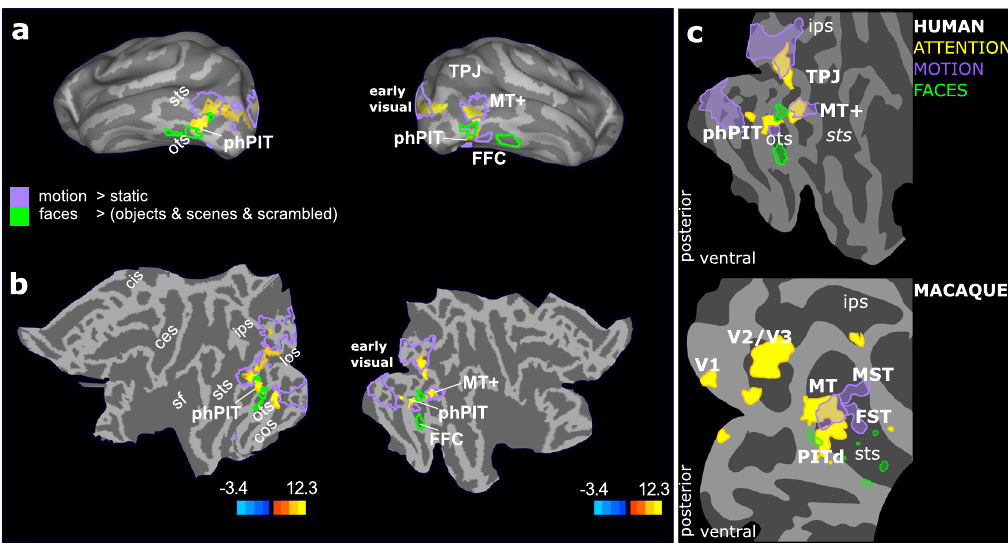
Fig. 4 phPIT functional pro fi le differs from nearby areas. a Statistical parametric maps of the contrast ‘ attend contralaterally versus ipsilaterally ’ overlaid on the inferior views of the average human in fl ated brain. Conventions as in Fig. 3a, b. Solid lines show visual selectivity for motion (purple) and faces (green). b Statistical parametric maps of the contrast ‘ attend contralaterally versus ipsilaterally ’ overlaid on fl at map of the left and right hemispheres; conventions as in panel A. The color-bar shows T -values task-related activations. c Schematic fl at-map representations of activation patterns in humans (top) and macaques (bottom). ces central sulcus, cos collateral sulcus, ips intraparietal sulcus, los lateral occipital sulcus, ots occipito-temporal sulcus, sf Sylvian Fissure, sts superior temporal sulcus, FFC fusiform Face Area, FST fundus of the superior temporal sulcus, LIP Lateral Intraparietal area, MT and MT + middle temporal area, MST medial superior temporal area, PITd Posterior Infero-Temporal dorsal area, phPIT putative human Posterior Infero- Temporal area, TPJ temporo-parietal junction, V1-2-3 visual areas